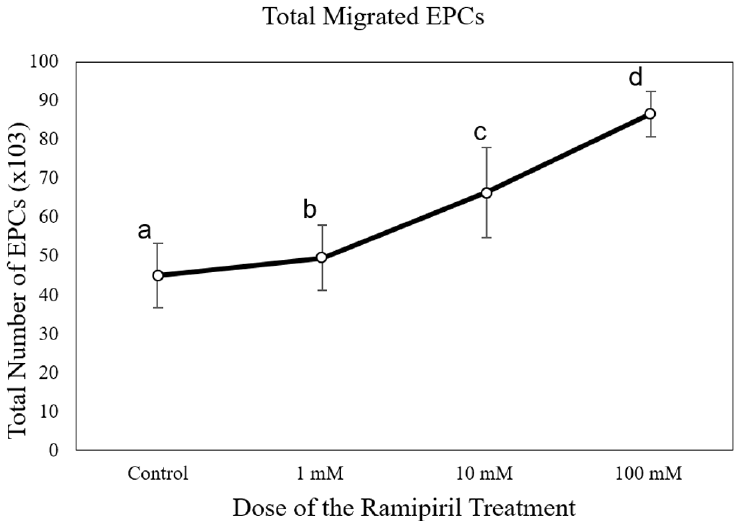
Figure 5. Total migrated endothelial progenitor cells (EPCs) on increasing dose of ramipiril treatment. Total migrated cells are expressed as mean ± SD (n = 4). Different annotations (a,b,c,d) denounce significant difference in ANOVA test (p<0.05).